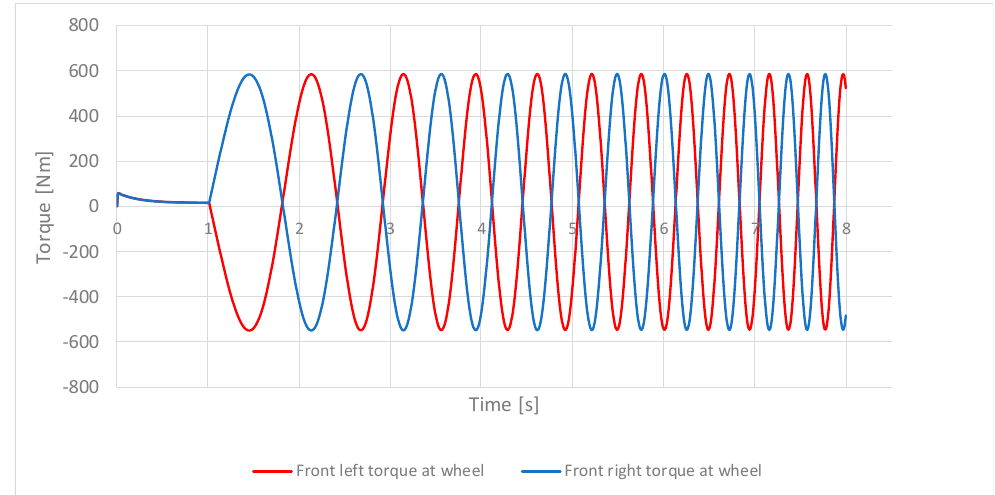
Figure 12. Front wheel torque at the ground on left (red) and right (blue) sides for vehicle with TV (Torque Vectoring), k = 600.